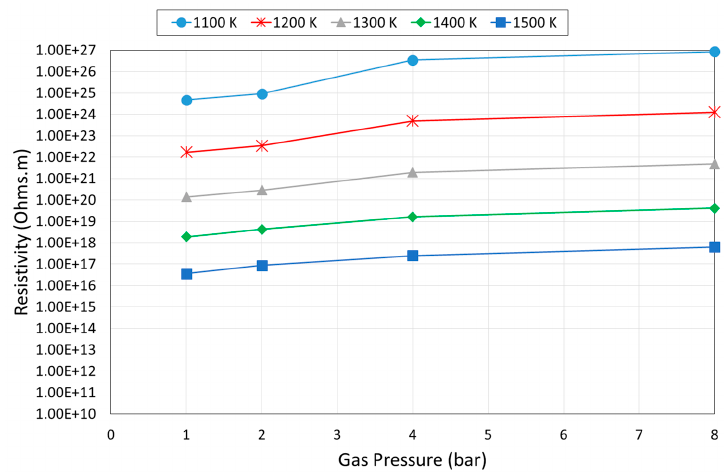
Figure 10. Resistivity of the SF 6 plasma at non-thermal regime versus gas pressure et different temperatures.